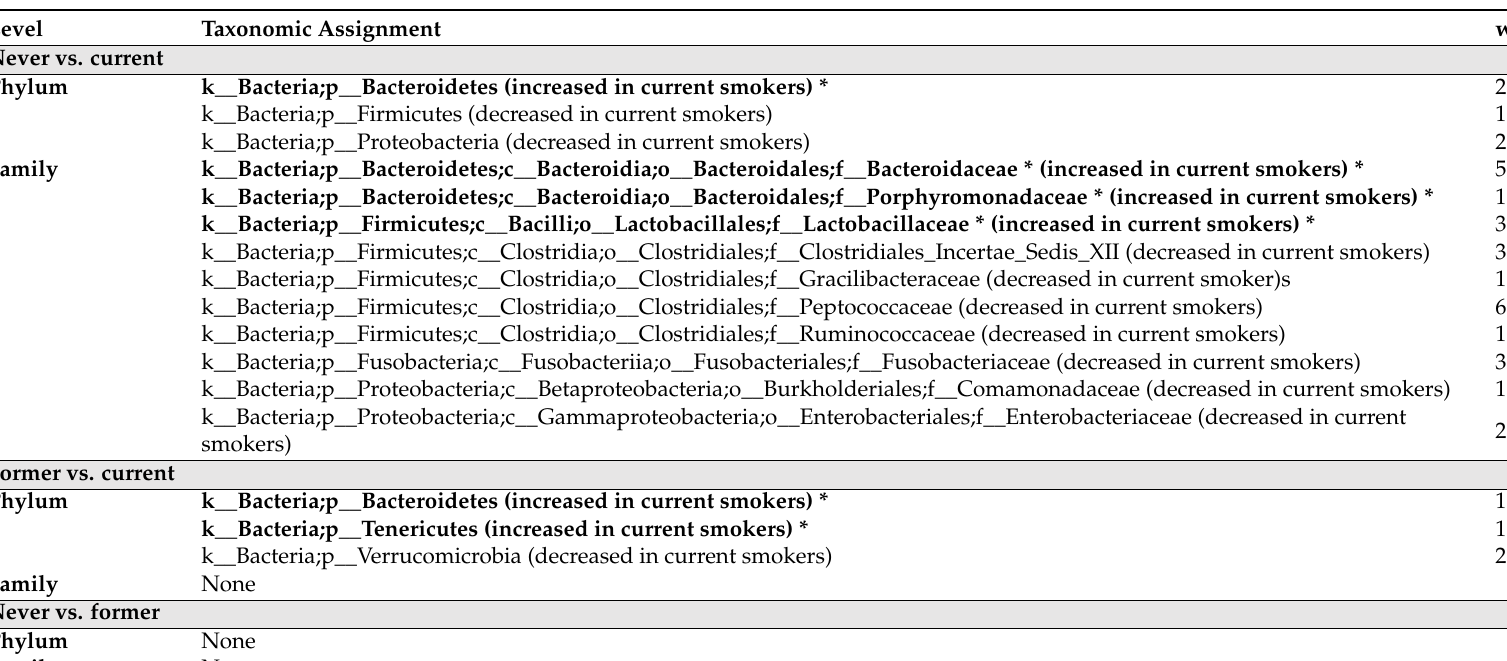
Table 2. Results of analysis of microbiome